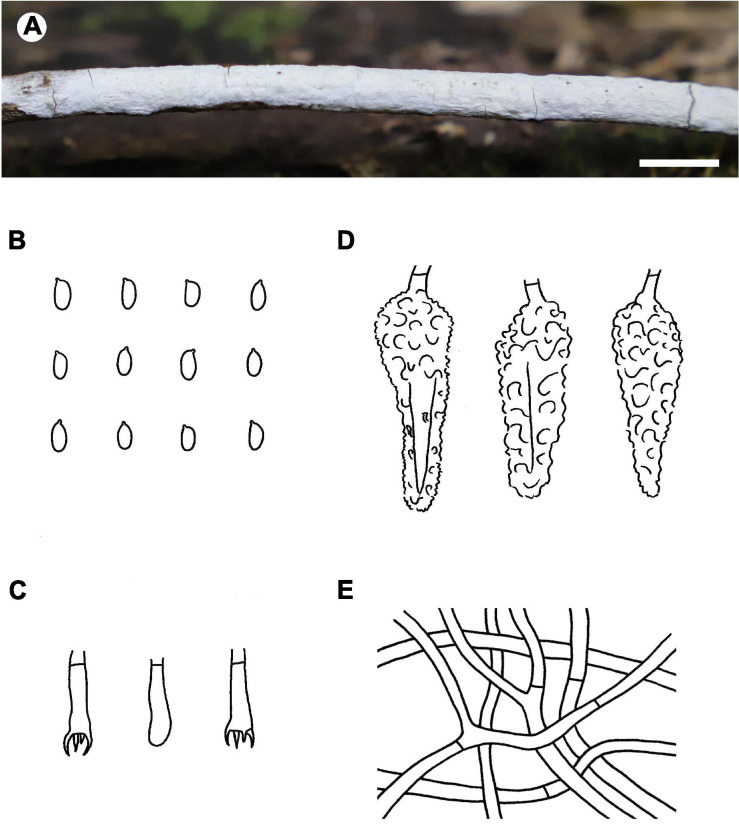
Phlebiopsis albescens [from the holotype He 5805; scale bars: A = 1 cm, B–E = 10 μm]. (A) Basidiomata; (B) basidiospores; (C) basidia; (D) basidioles; (E) lamprocystidia.